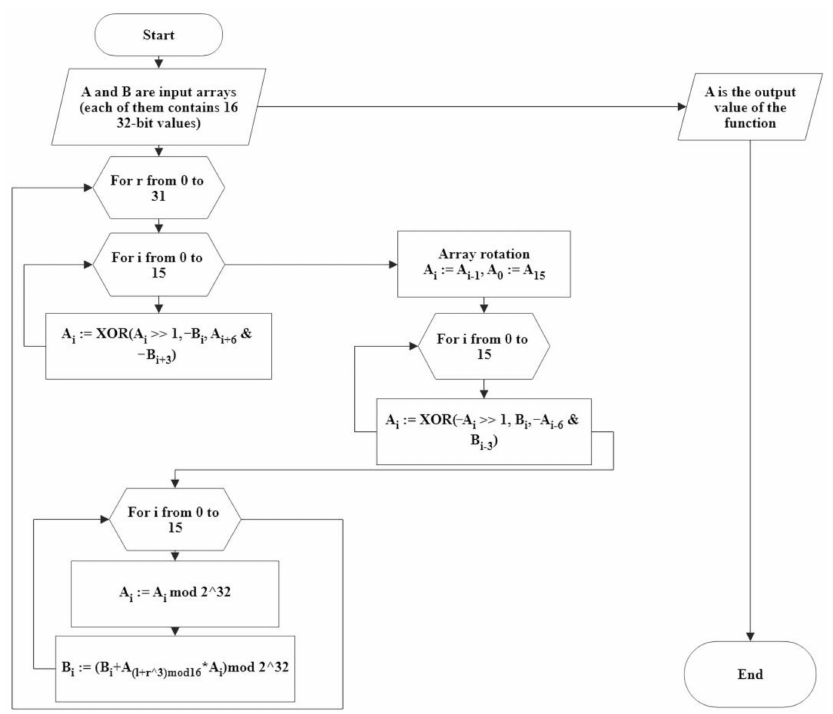
Figure 3. The flow chart of the compression